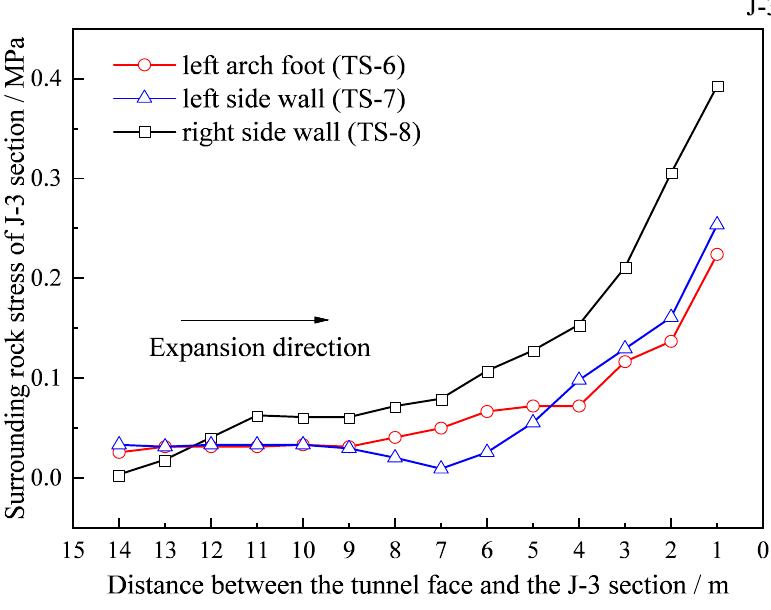
Figure 7. Stress change curve of J-3 section.